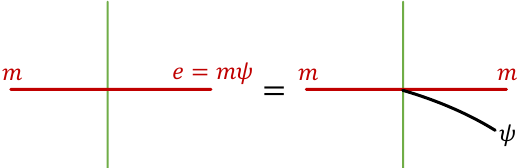
Figure 11: We can think of this e ↔ m twist string as the ψ line coming out from the intersection of m -line and the twist string.